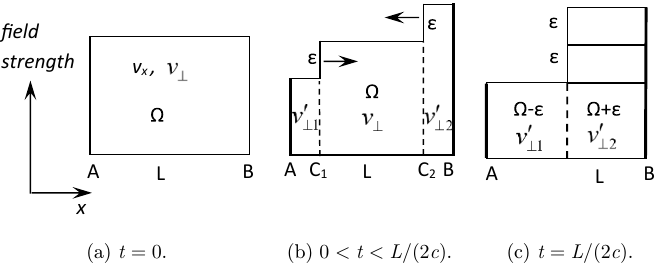
Fig. 12. A ¯eld block with initial lateral speed being blocked to